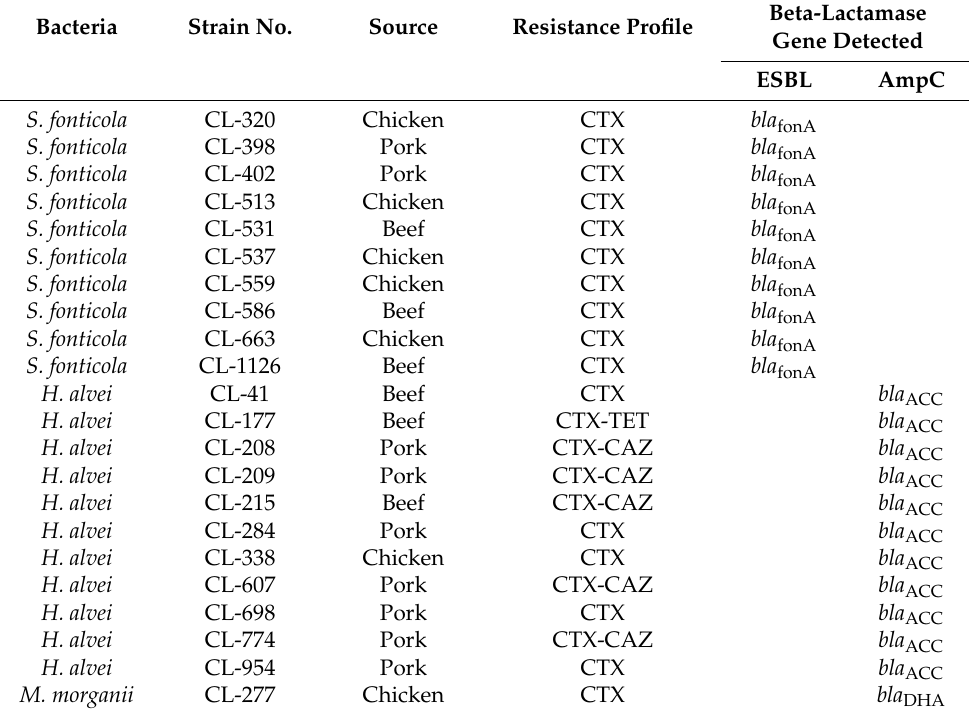
Table 3. Resistance profiles and associated resistance genes identified in third-generation cephalosporin-resistant bacteria isolated from retail chicken, pork, and beef purchased in Japan. Bacteria